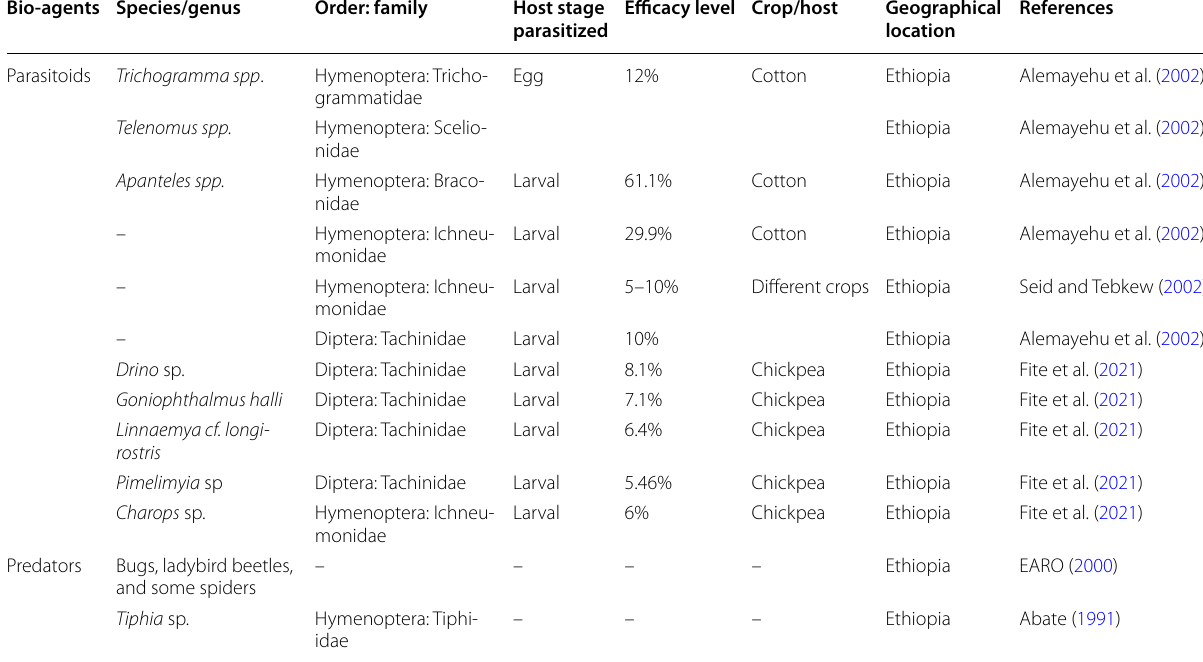
Table 1 Natural enemies of H. armigera in Ethiopia Bio-agents Species/genus Order: family Host stage